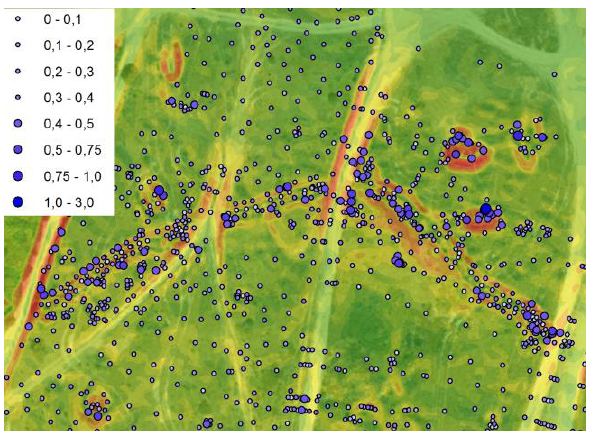
Table 3. Main characteristics of accuracy according to slope (points on micro-relief objects excluded)